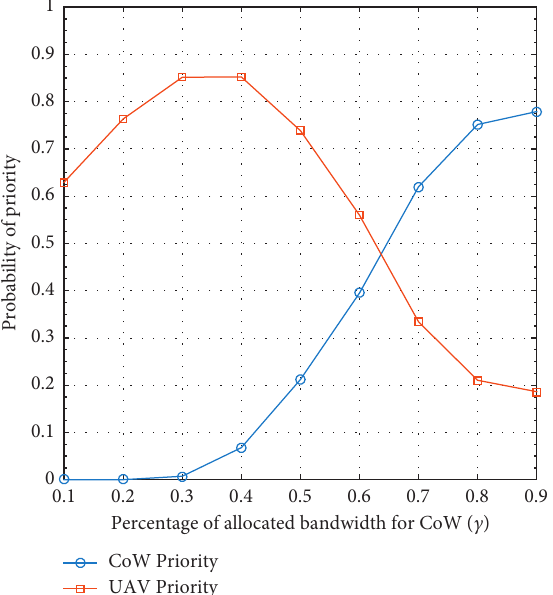
Figure 4: Probability of priority versus the percentage of band- width given to the CoW ( c ) .